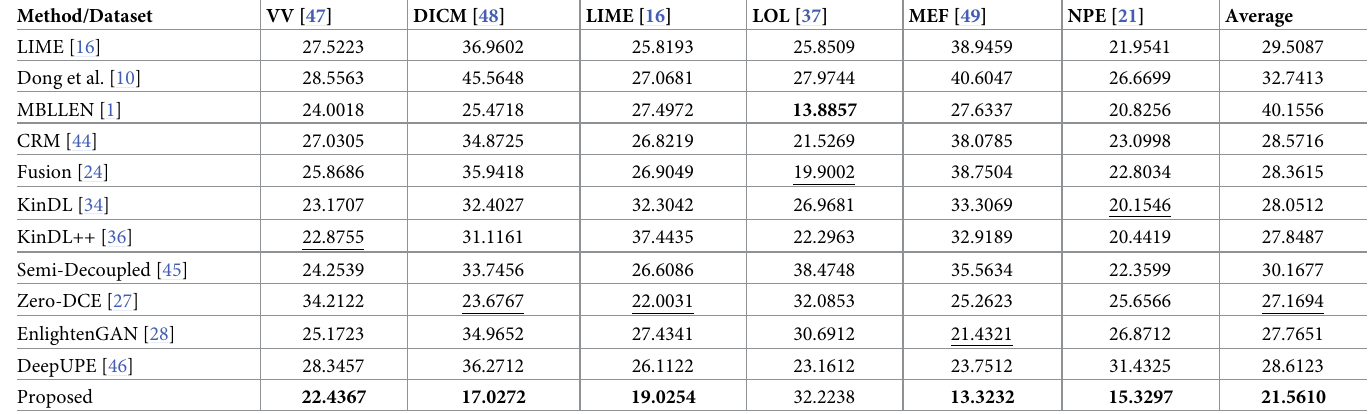
Table 4. Blind/Referenceless Image Spatial Quality Evaluator (BRISQUE) comparsion between nine low light enhancement methods on six different datasets. Best score is in bold and second best is underlined.